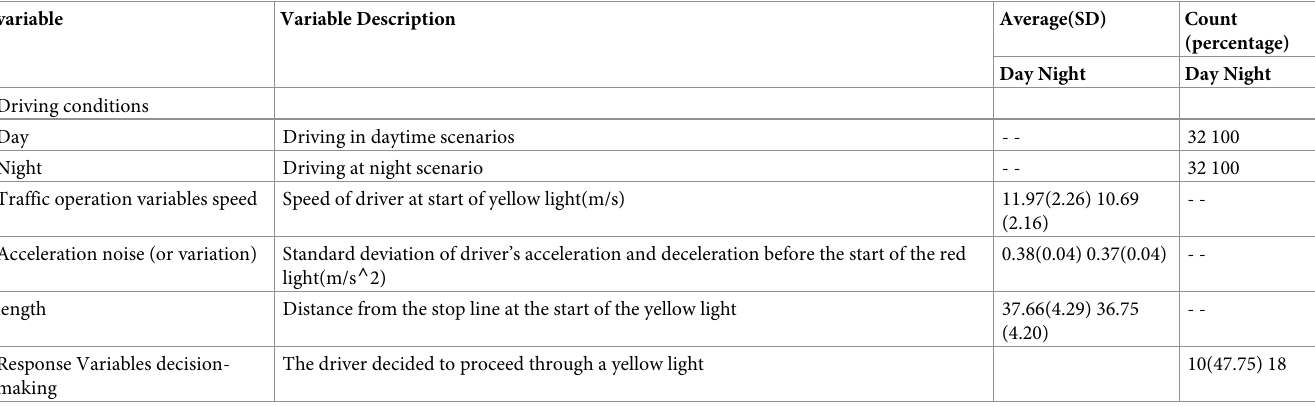
Table 1. Summary statistics of operation and response data for each driving